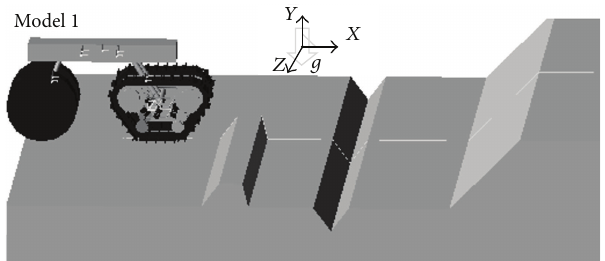
Figure 9: Virtual prototype of the wheel-tracked exploration robot.